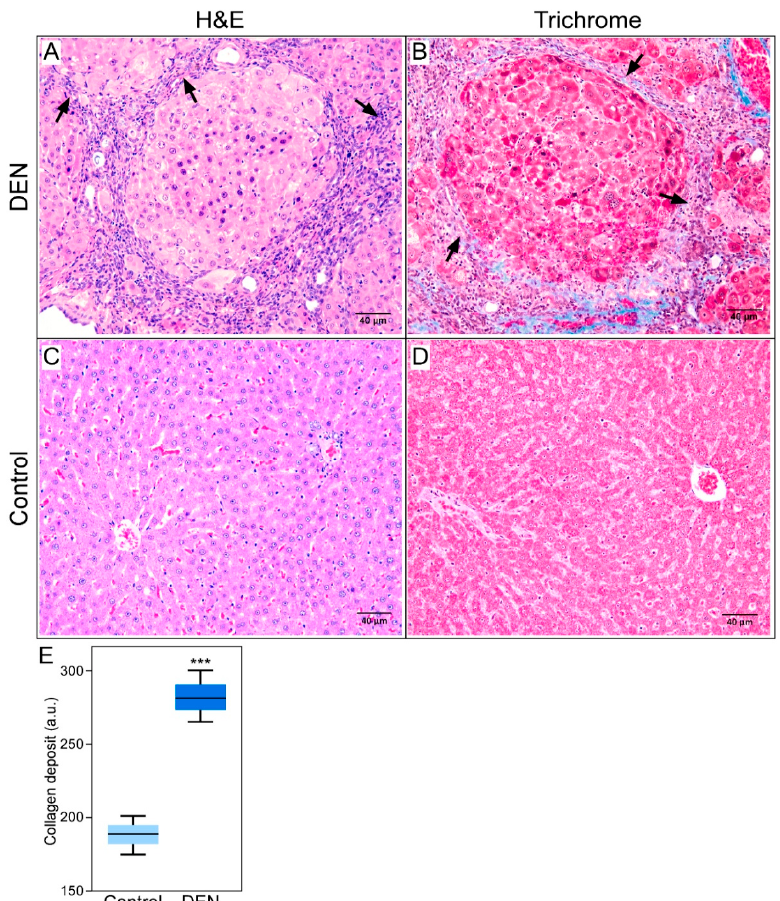
Figure 7. Hepatic histopathology following 13 weeks of DEN treatment. The tissue samples taken from animal subjects 13 weeks after they had started drinking DEN ‐ infused water were processed for histological examination with ( A ) H&E or ( B ) trichrome staining, and imaged under microscope. The H&E and trichrome stains show numerous septa (arrows) formed by deposits of collagen fibers. Liver tissue samples taken from control rats showed normal liver cells without any deposits of collagen fibers in H&E ( C ) or trichrome staining ( D ). The fibrous tissues stained blue on trichrome stain are the deposits of collagen fibers which characterize hepatic fibrosis. Scale bar = 40 μ m. Histologic sections ( A , B ) were graded METAVIR score of F4, and ( C , D ) F0. ( E ) Boxplots showing quantification of collagen deposits in the control and DEN ‐ fed rats. The difference between the mean collagen deposits is statistically significant (*** for p < 0.001).